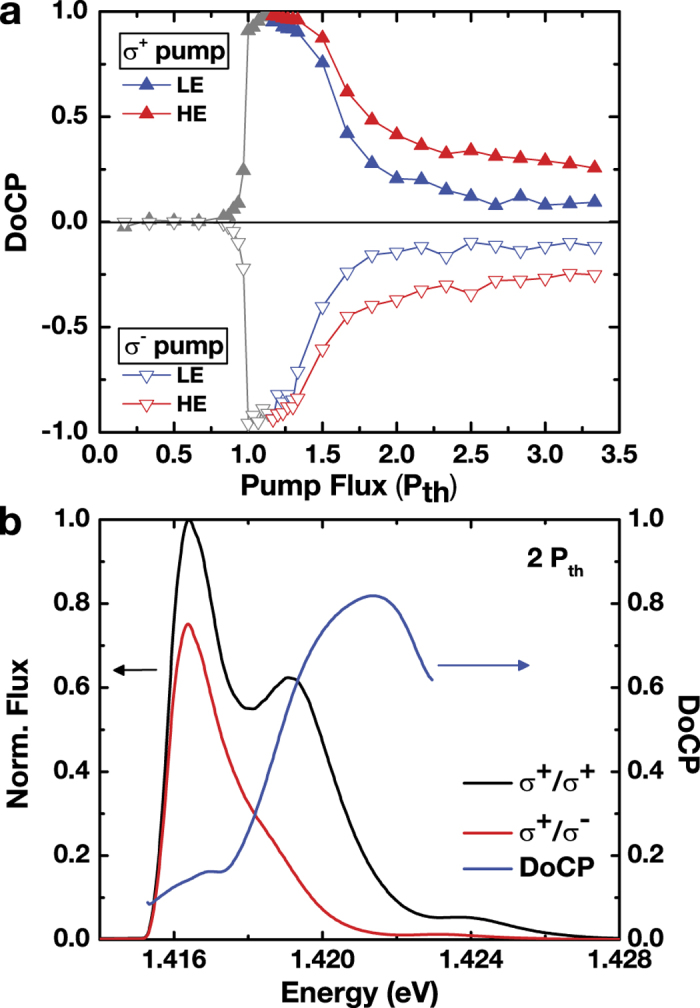
Polarization Properties.(a) Stationary degree of circular polarization  of the HE state (solid and open red triangles) and LE state (solid and open blue triangles) under circularly polarized σ+ pump (upper part, solid triangles) or σ− pump (lower part, open triangles). , where A± refers to the areas of co-circular (A+) and cross-circular (A−) components of the HE and LE spectral peaks and are obtained by fitting of the time-integrated spectra (Fig. 1) with multiple-Gaussian functions. The  of the HE states increases from zero to near unity for  and decreases gradually to 0.25. The  of the LE states is relatively high (>0.8) initially, but it decrease rapidly to less than 0.1 when the pump flux is increased above 2.0 Pth. (b) The time-integrated polarized spectra  of the co-circular , black curve) and the cross-circular , red curve) components at P = Pth. The energy-dependent  (blue curve) shows a maximal , which is significantly larger than the spectrally averaged  shown in (a).